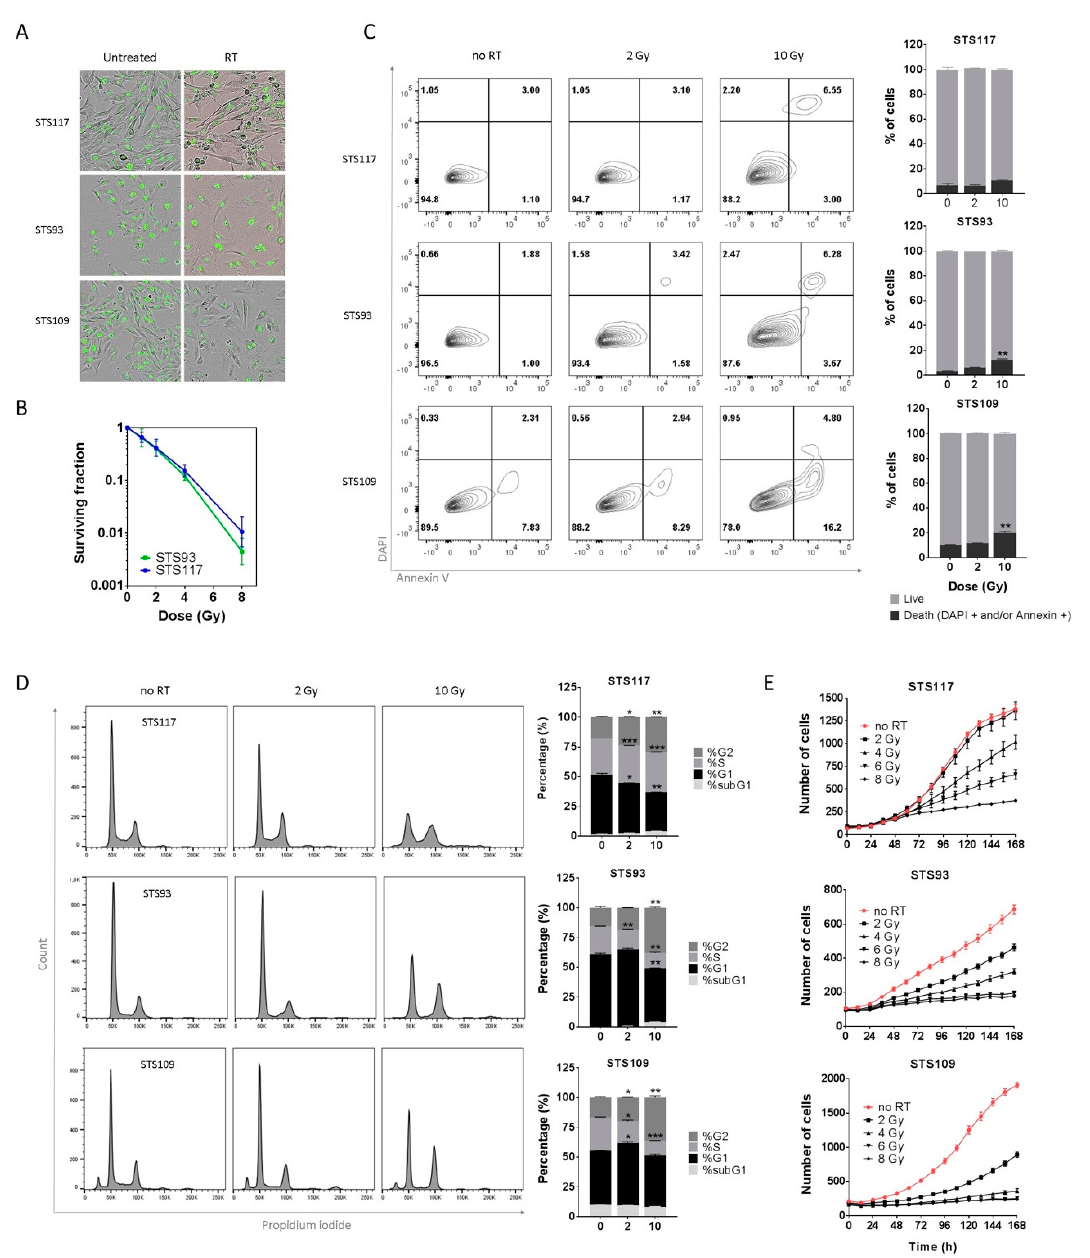
Figure 1. Radiation induces cytostatic effects in sarcoma cell lines. ( A ) Representative picture of the three undifferentiated pleomorphic sarcoma (UPS) cell lines, untreated or 5 days after treatment (8 Gy). ( B ) Clonogenic survival assay of STS93 and STS117 treated with 0, 0.5, 2, 4 and 8Gy of radiation. Cell survival is normalized to the clonogenic formation from untreated cells (0Gy). ( C , D ) Cell death and cell cycle analyzed by flow cytometry 48 h after exposure to radiation (0, 2 and 10 Gy). In the graph, percentage of cell death ( C ) represents the sum of Annexin V positive cells (both DAPI positives and negatives) and DAPI positive cells (Annexin V negatives) from the quadrant plots of DAPI vs. Annexin V. ( E ) Cell proliferation curves of sarcoma cell lines expressing H2B-GFP and exposed to increasing doses of radiation (0, 2, 4, 6 and 8 Gy). Student’s t-test, * p < 0.05, ** p < 0.01, *** p < 0.001. Data are representative of two to three experiments. Error bars represent ± standard